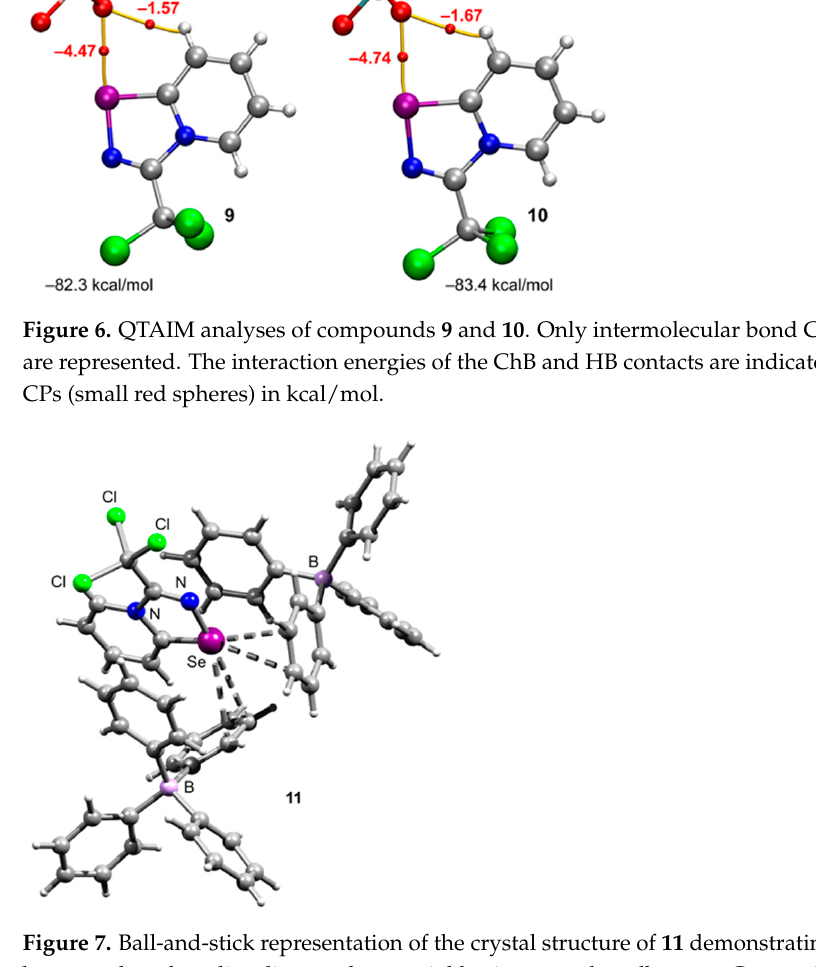
Figure 8. QTAIM analyses of two dimers of compound 11 . Only intermolecular bond CPs and bond paths are represented.